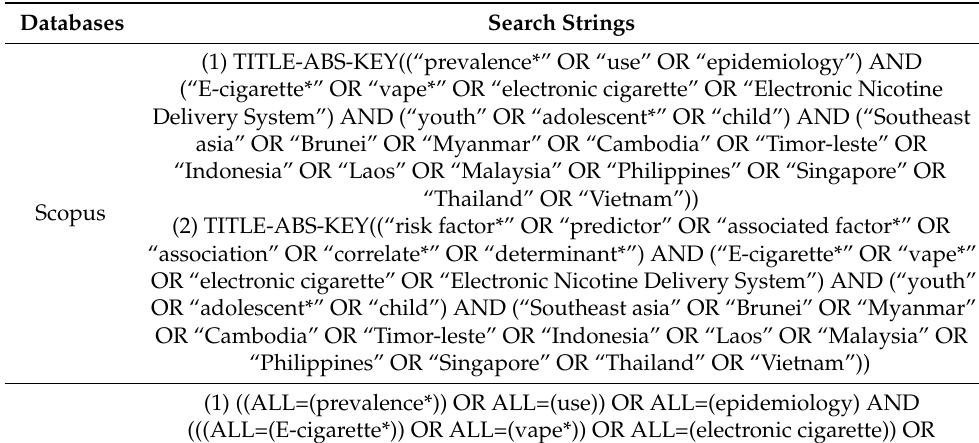
Table 1. Keywords used for